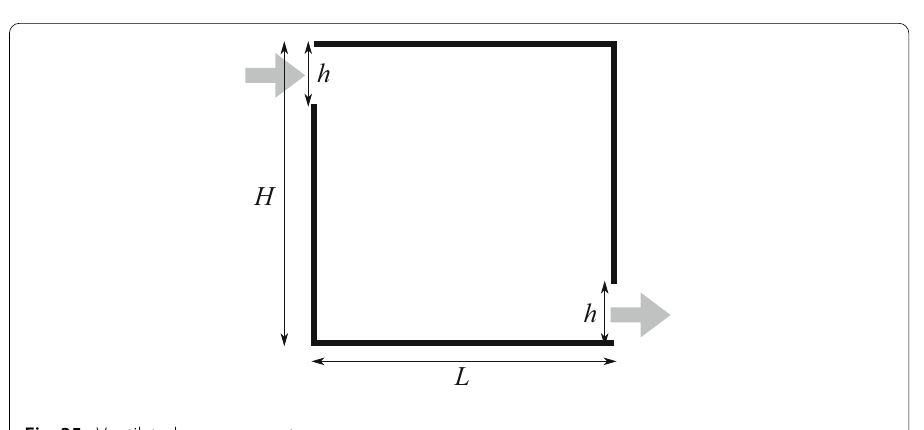
Fig. 35 Ventilated-room